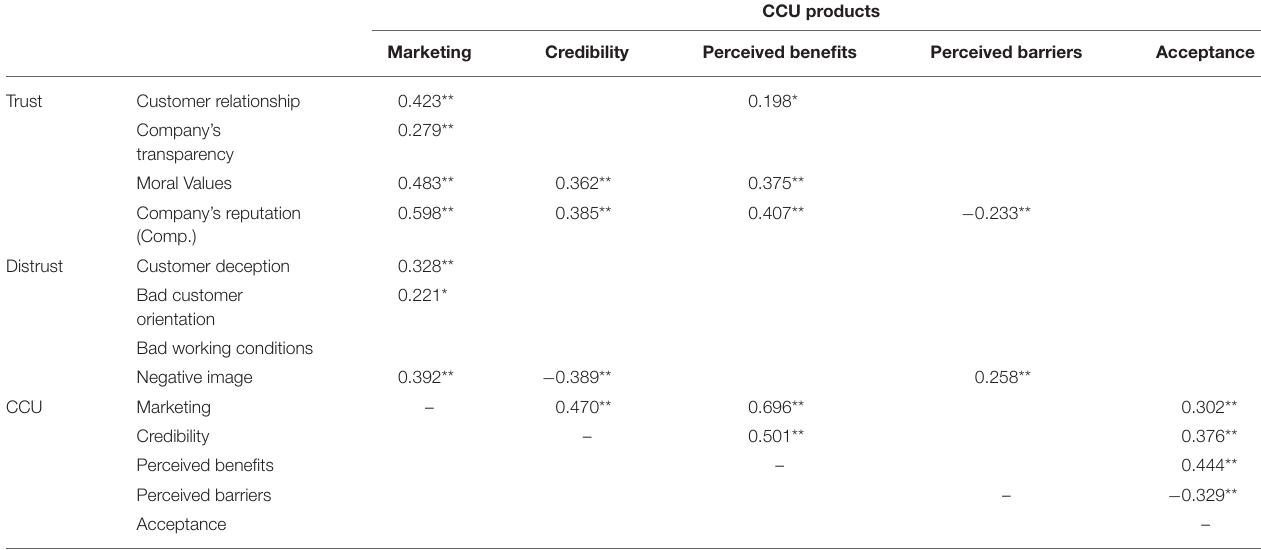
TABLE 5 | Results of correlation analysis: relationships between (dis)trust, credibility, and the perception of CCU